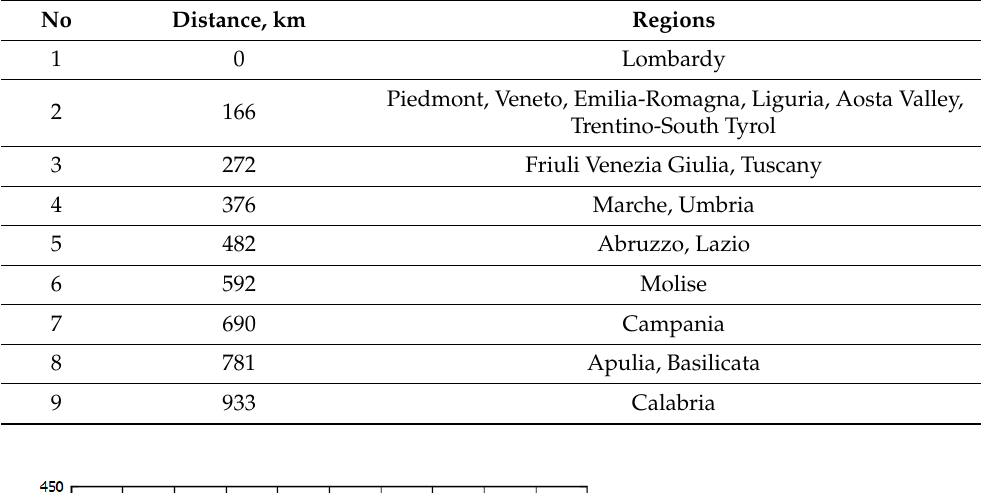
Table 1. Regions to bands correspondence in Italy.